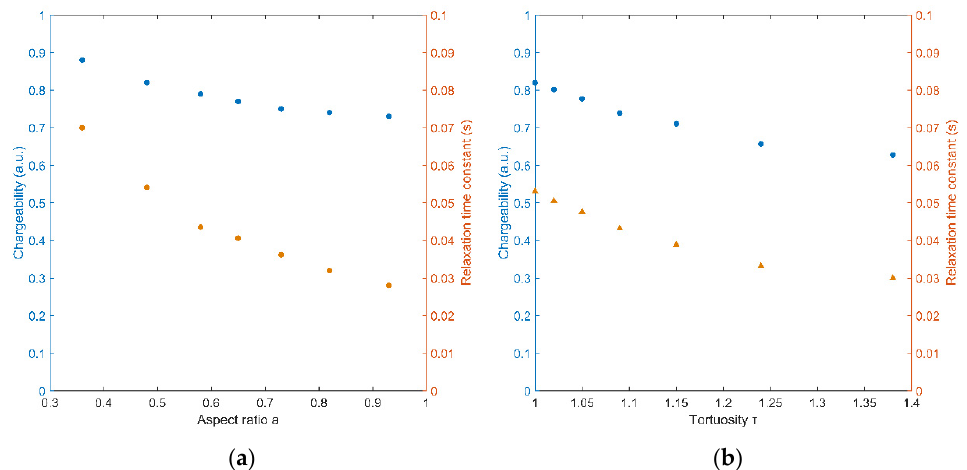
Figure 5. Dependence of the total chargeabilities and relaxation time constants of seafloor sulfide- bearing rocks on the aspect ratios and tortuosities of metal sulfides. ( a ) The total chargeabilities, M, and the relaxation time constants, τ , for the seafloor massive metal sulfide models with various aspect ratios. ( b ) The total chargeabilities, M, and relaxation time constants, τ , for the seafloor vein metal sulfide models with various tortuosities.